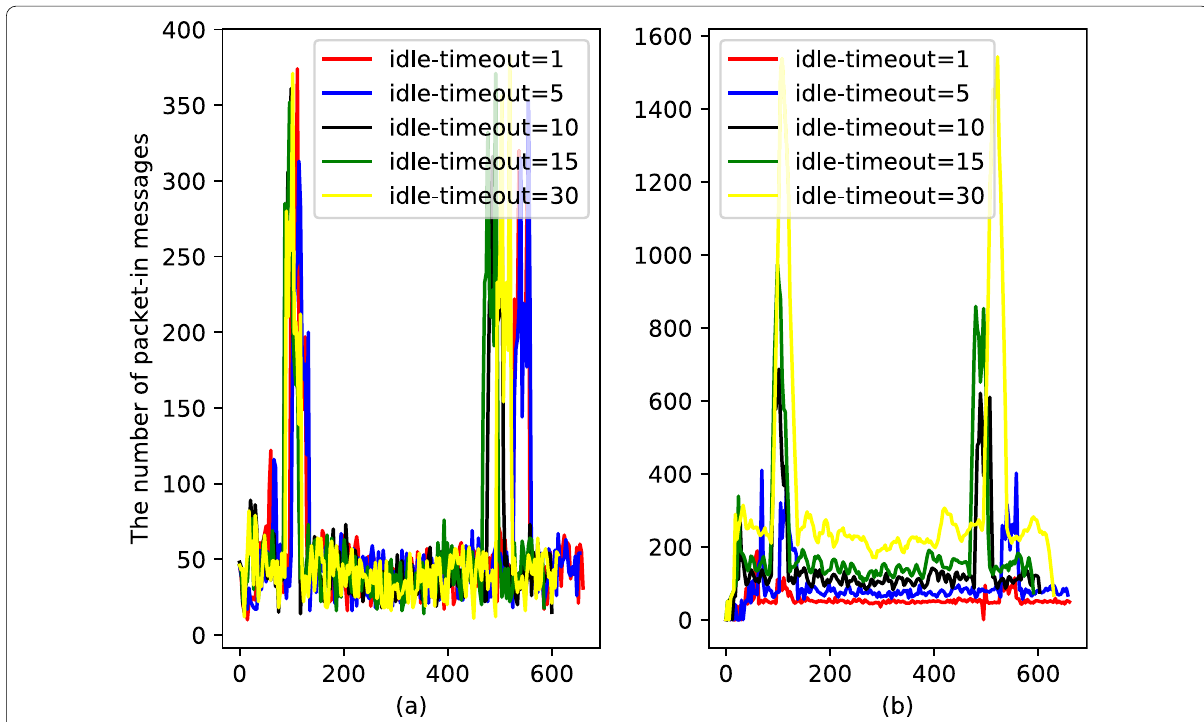
Fig. 5 The number of flow rules and packet-in messages with different idle-timeout values